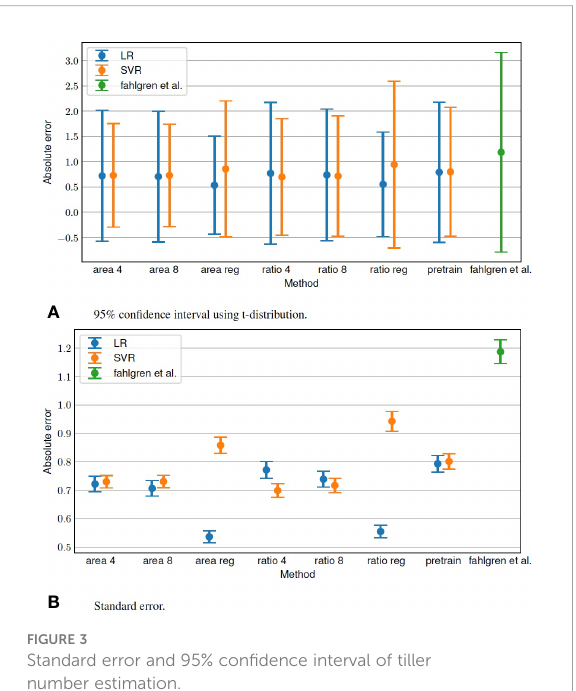
FIGURE 3 Standard error and 95% con fi dence interval of tiller number